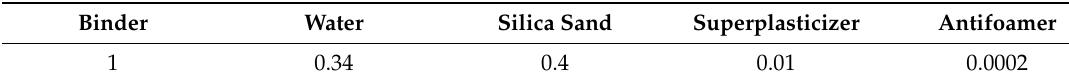
Table 4. Mixture proportion of matrix (weight ratio).